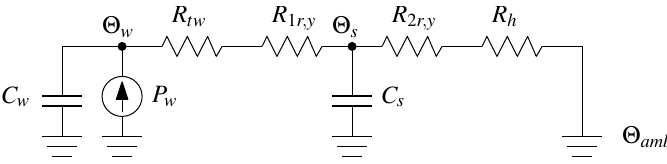
Figure 10. Simplified thermal equivalent circuit (TEC) of the